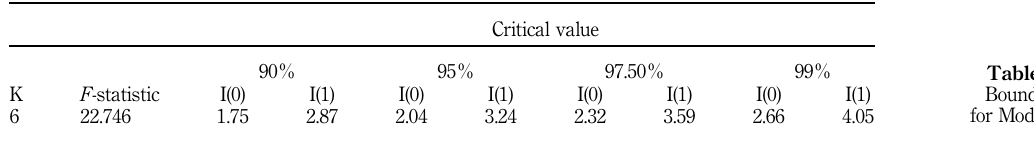
Table III. Results of the unit root test of stationary of two models